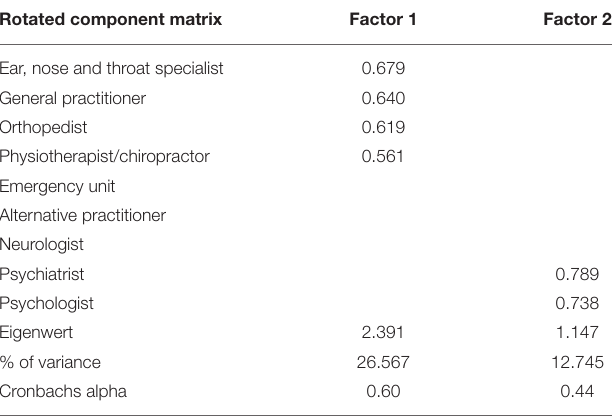
( Table 4 ). In the logistic regression, the likelihood of consulting somatic-oriented healthcare providers was higher for a lower ACQ and shorter disease duration of vertigo. However, the explained variance in this model was low ( Table 5 ).